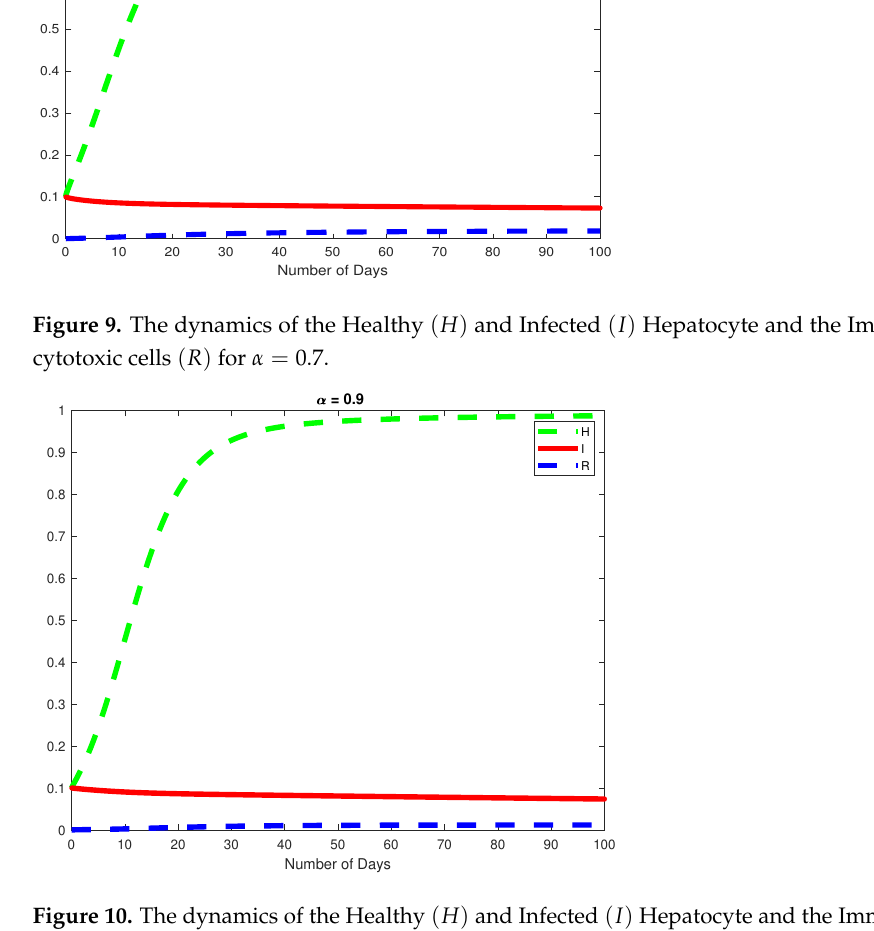
Figure 10. The dynamics of the Healthy ( H ) and Infected ( I ) Hepatocyte and the Immune response cytotoxic cells ( R ) for α =